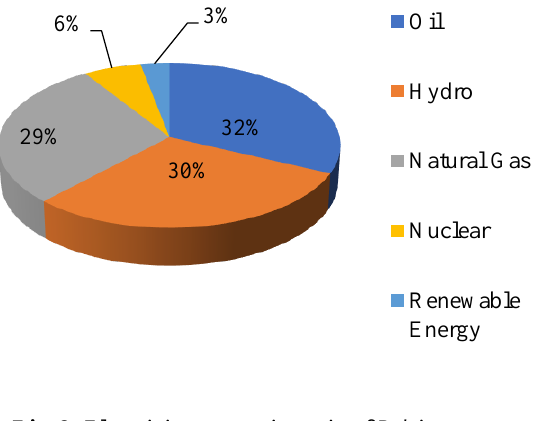
Fig. 3. Electricity generation mix of Pakistan